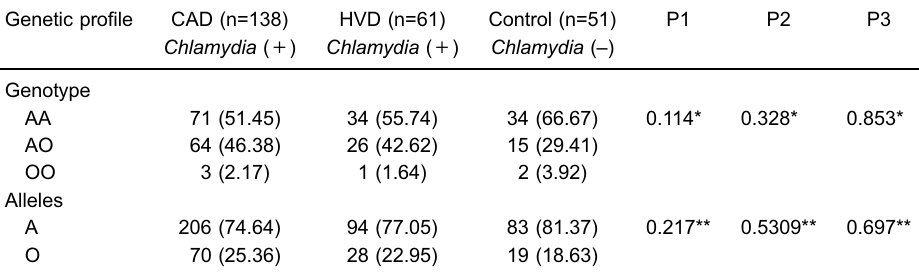
Table 2. Distribution of genotype and allele frequencies among Chlamydia- positive patients with coronary artery disease undergoing coronary artery bypass surgery (CAD) and with heart valve disease undergoing valve replacement (HVD), and a control group with no Chlamydia